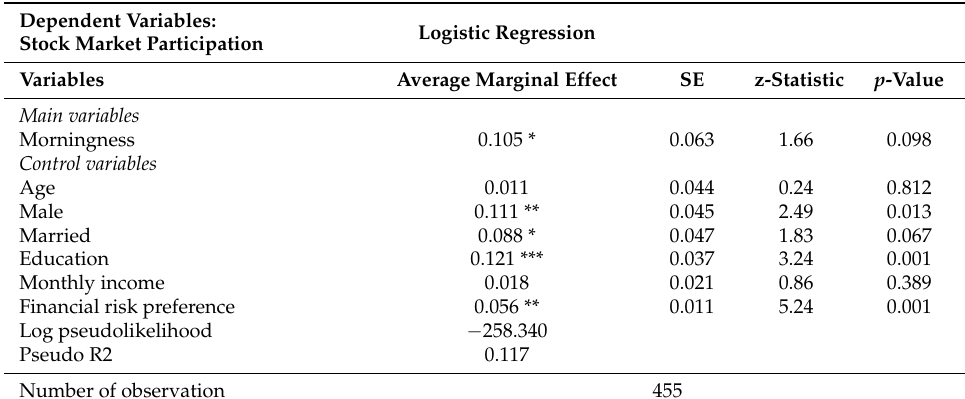
Table 7. The effect of morningness on stock market participation based on logistic